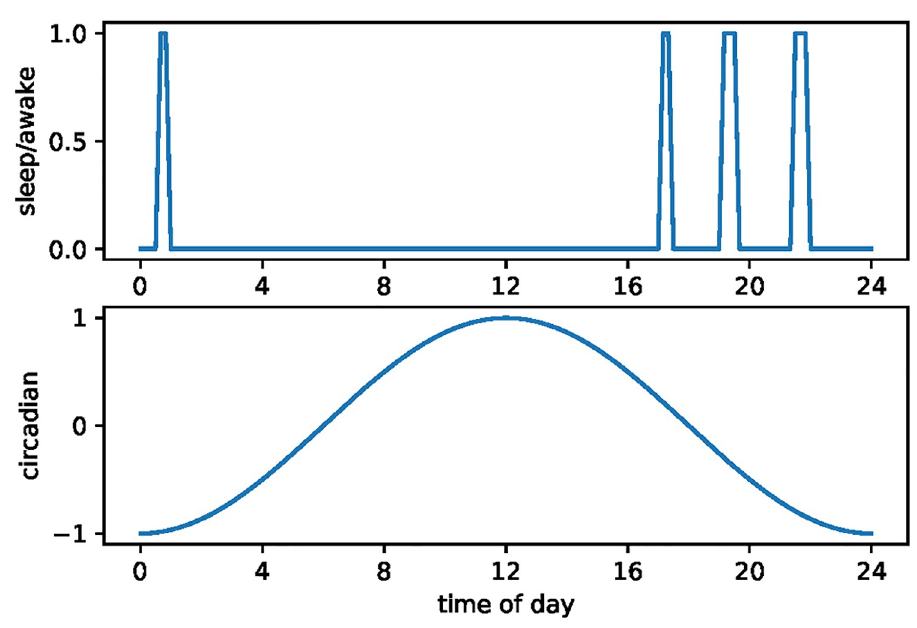
Fig 5. Stylized elephant sleep